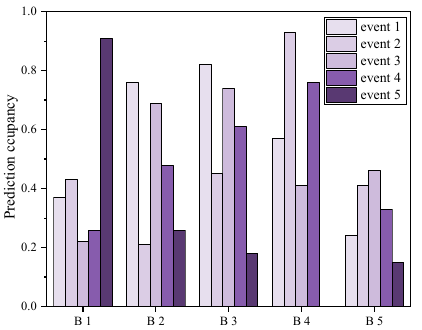
Figure 5. Predicted occupancy rate of targeted buildings at typical events.